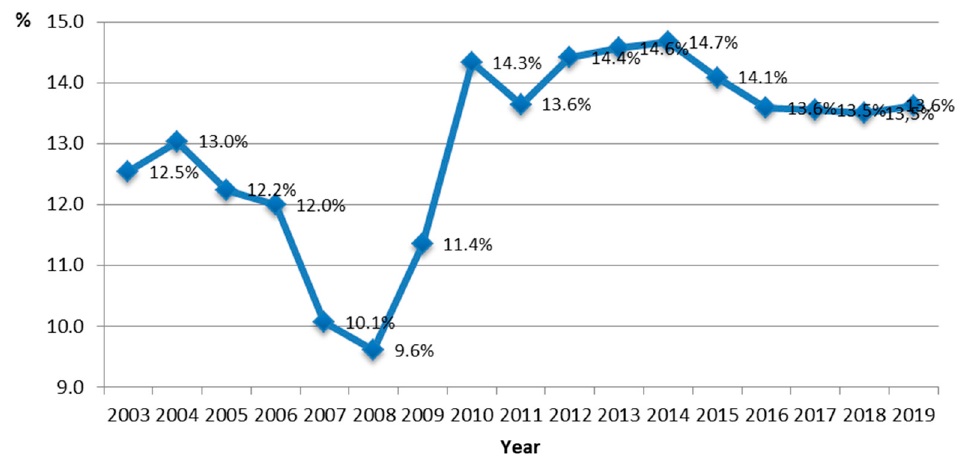
Figure 4. Sigma-convergence analysis of the gross value added per person employed in section A (agriculture, forestry, hunting, and fishing) for voivodeships (Own study, based on the Local Data Bank).